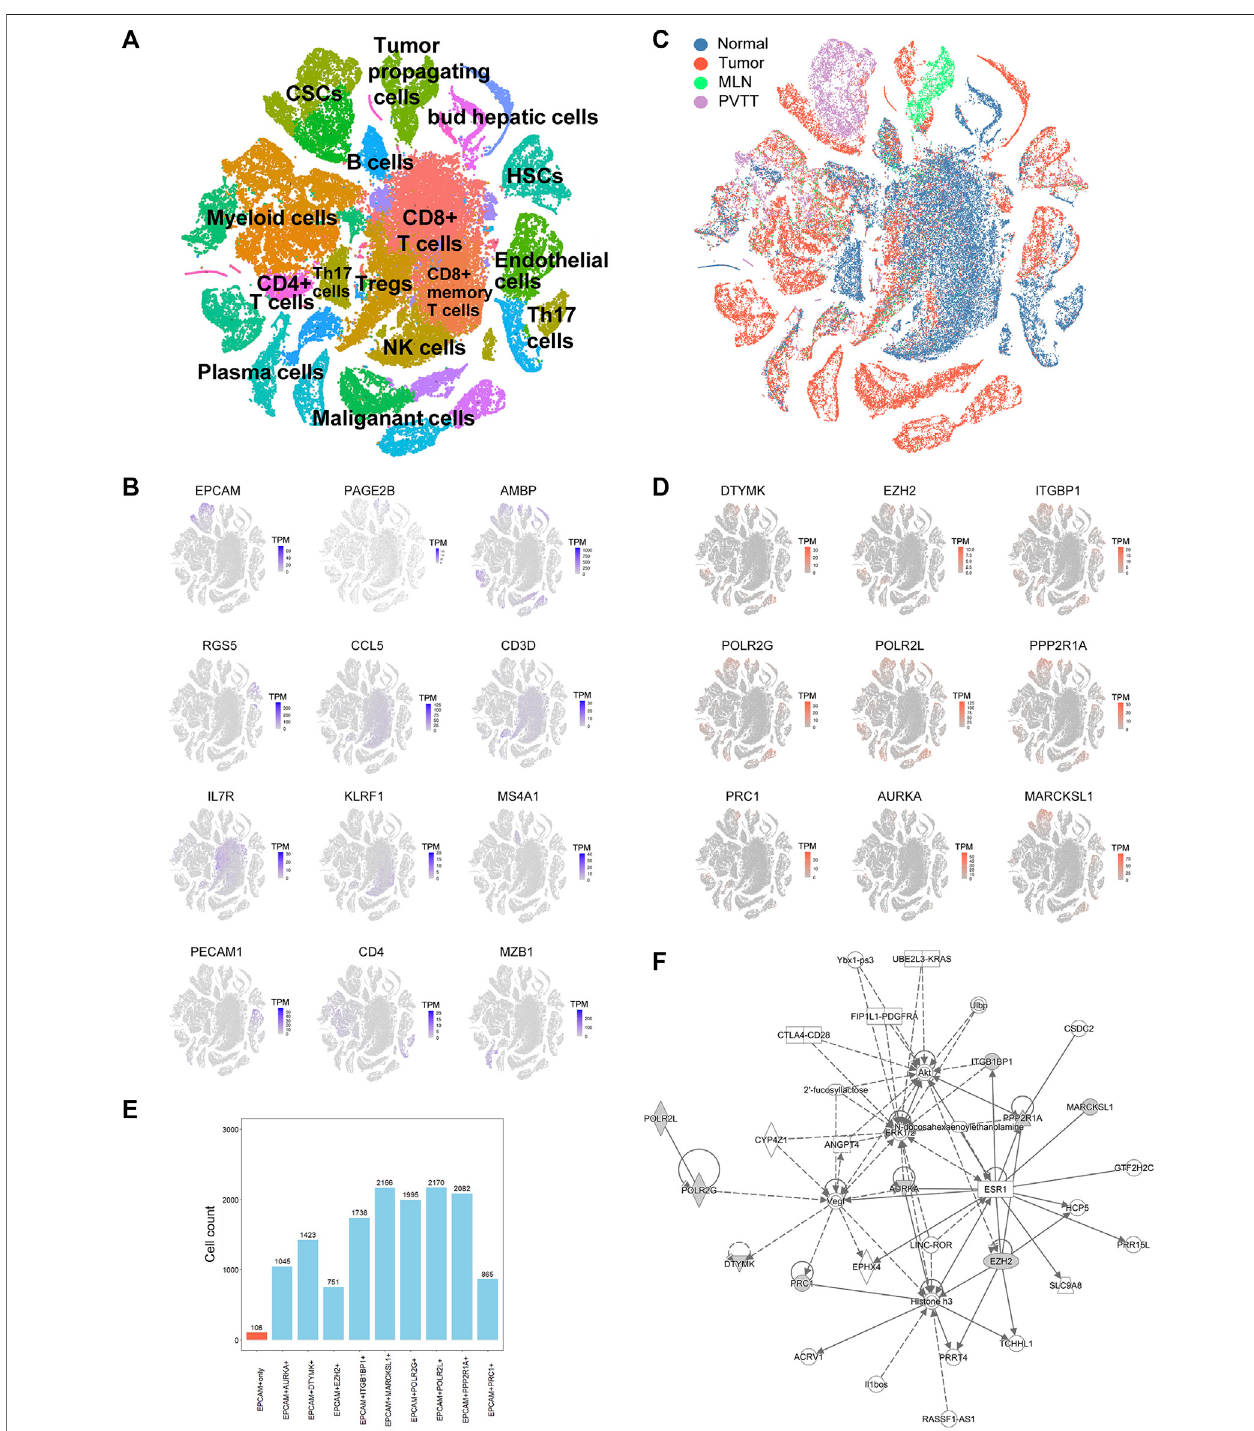
FIGURE3| Single-cell RNAsequencing (ScRNA-seq) analysis ofHCC patients. (A) t-SNE clusteringofscRNA-seq coloredby signi fi cantcelltypes. (B) t-SNE plot of expression for genes speci fi cally upregulated in each of the clusters. (C) t-SNE clustering of scRNA-seq as in (A) but colored by patient type. Normal: nontumor liver, Tumor: primary tumor, MLN: metastatic lymph node, PVTT: portal vein tumor thrombus. (D) t-SNE plot of expression for nine PRGs that were signi fi cantly highly expressed in tumor-related cell clusters. (E) Statistics of the cell counts of the nine PRGs coexpressed with EPCAM in 2,795 cancer stem cells (CSCs). (F) Regulatory network analysis of the nine PRGs using Ingenuity Pathway Analysis (IPA).